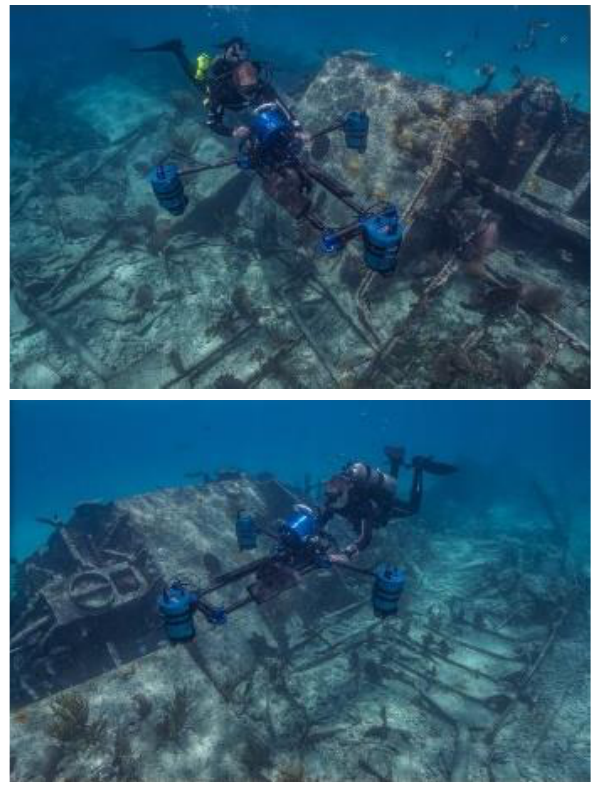
Figure 5. The SeaArray employed in the acquisition phase on the Mandalay archaeological site ( Biscayne National Park – Florida –